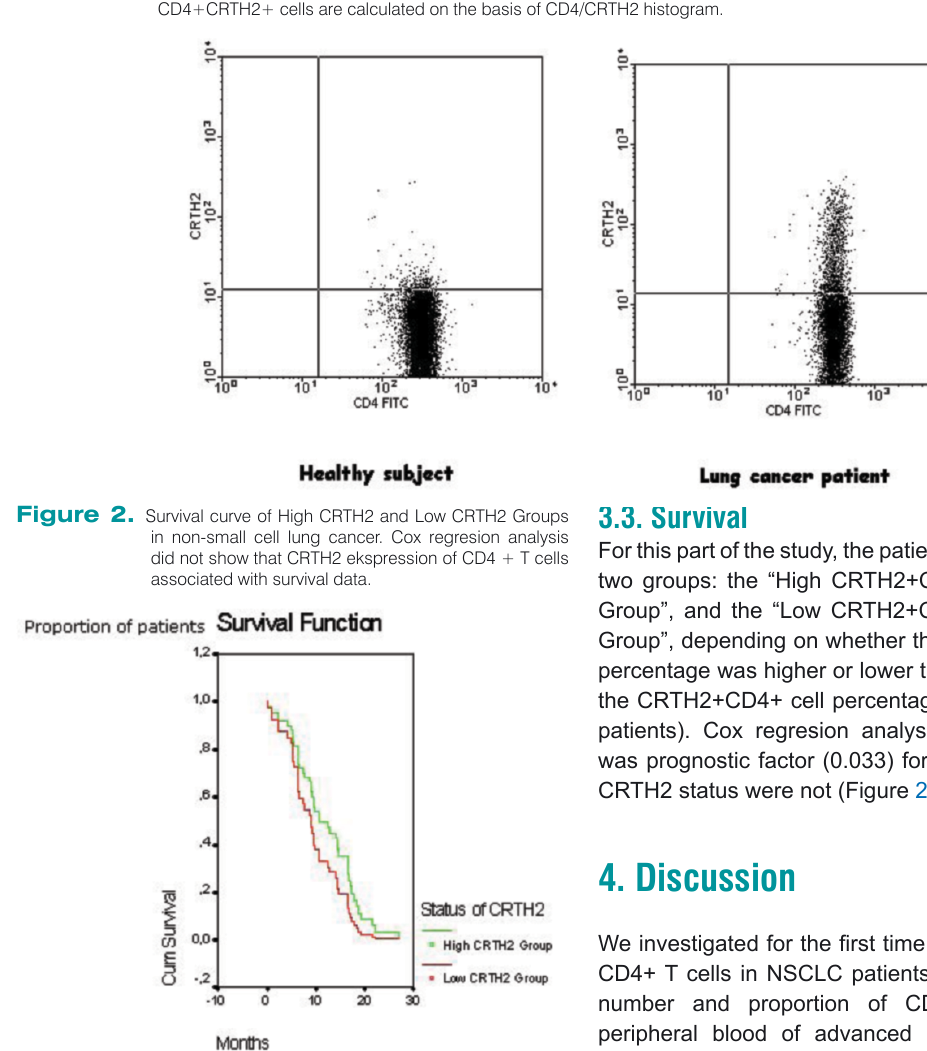
Figure 1. Identification of CRTH2 expressing cells by flow cytometry. First lymphocytes, and then CD3+CD4+ cells were gated. Thus CD4+CRTH2+ cells are calculated on the basis of CD4/CRTH2 histogram.